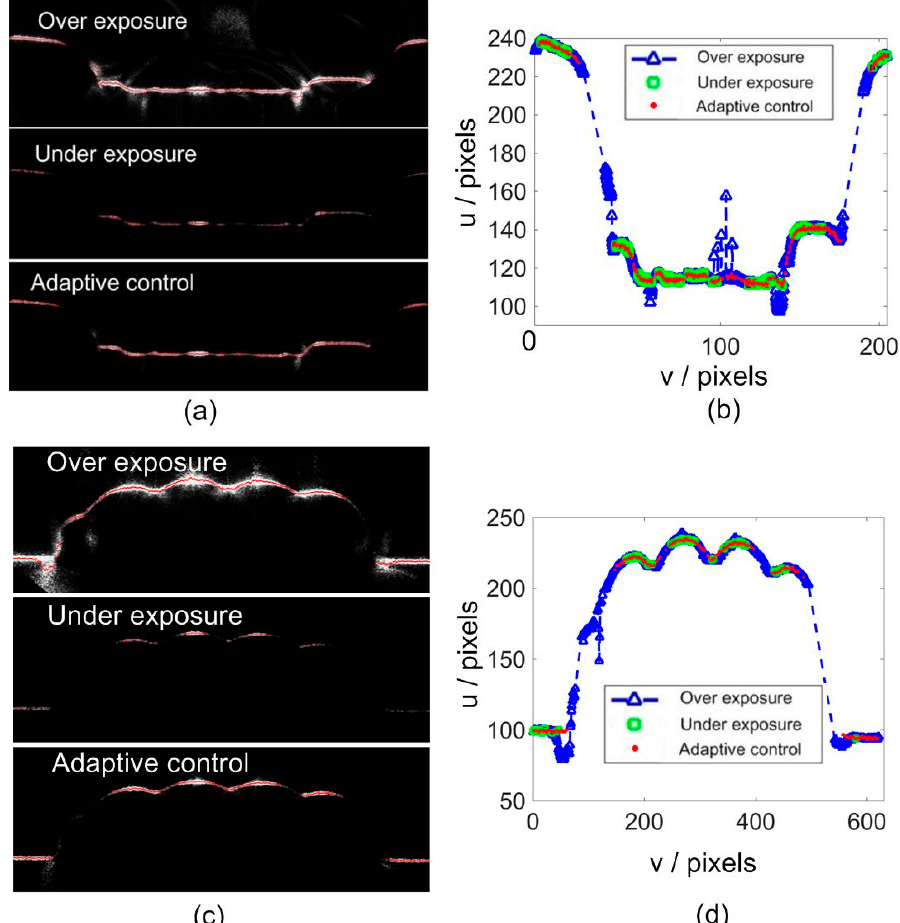
Figure 12. Comparison of center extraction results under different exposure conditions. ( a , c ) Stripe images; ( b , d ) center extraction results.